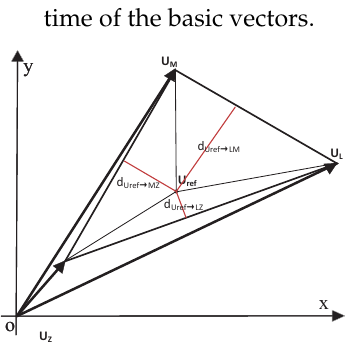
Figure 3. Process of vector